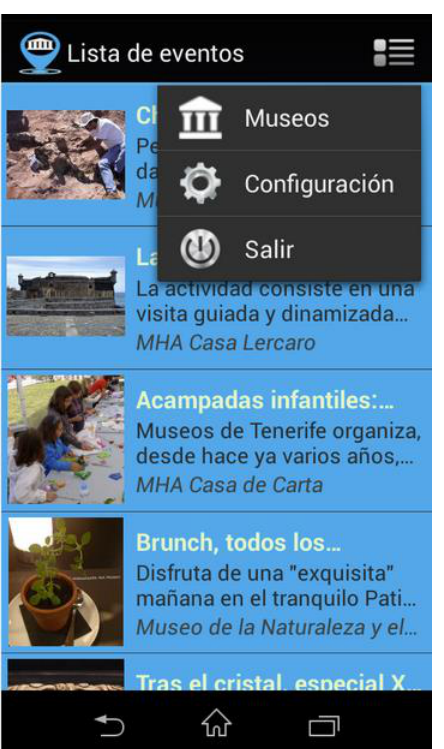
Figure 1: Screenshot of an app developed using the museums